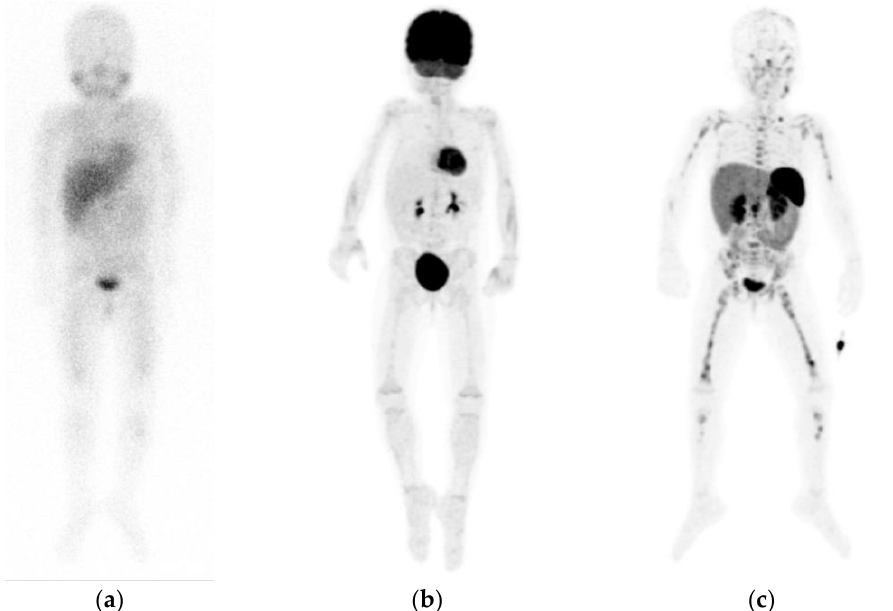
Figure 3. Example of a patient with neuroblastoma, showing diffuse pathological but faint osteomedullary uptake on planar [ 123 I]mIBG scintigraphy ( a ), without increased uptake on [ 18 F]FDG positron emission tomography (PET) maximum intensity projections (MIP) ( b ), but extensive pathological osteomedullary uptake on [ 68 Ga]Ga-DOTATATE PET MIP ( c ). Note the different physiological distribution between tracers.